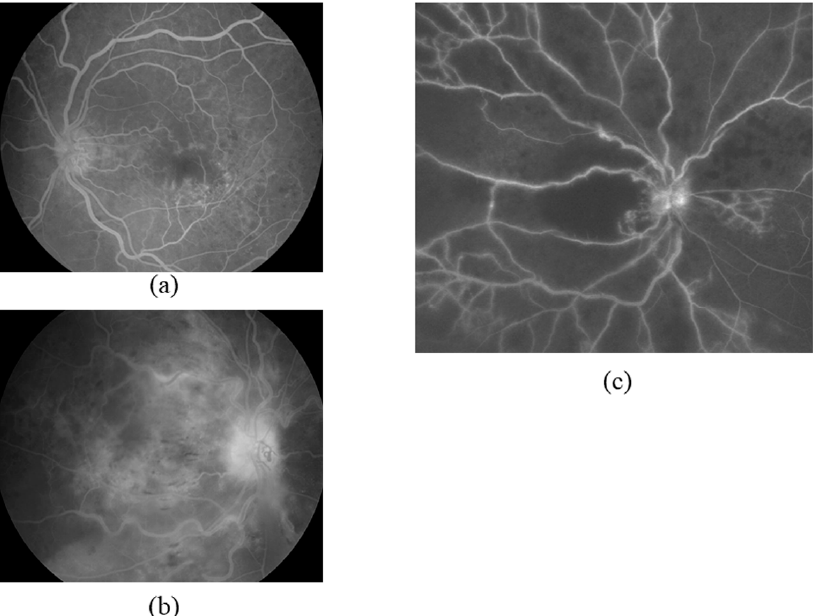
Figure 2. Representative fluorescein angiograms indicating that the severity of ischemia correlates to the concentration of vascular endothelial growth factor (VEGF) in the aqueous humor in cases of retinal nonperfusion. Values shown are aqueous VEGF levels; they are typical of values observed in mild, moderate, and severe cases of ischemia. ( a ) Mild ischemia (41,3 pg / mL). ( b ) Moderate ischemia (327 pg / mL). ( c ) Severe ischemia (1572 pg /